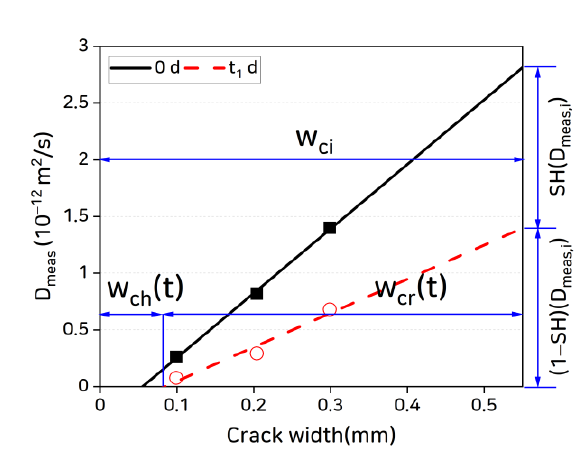
Figure 10. Healed crack width concept.